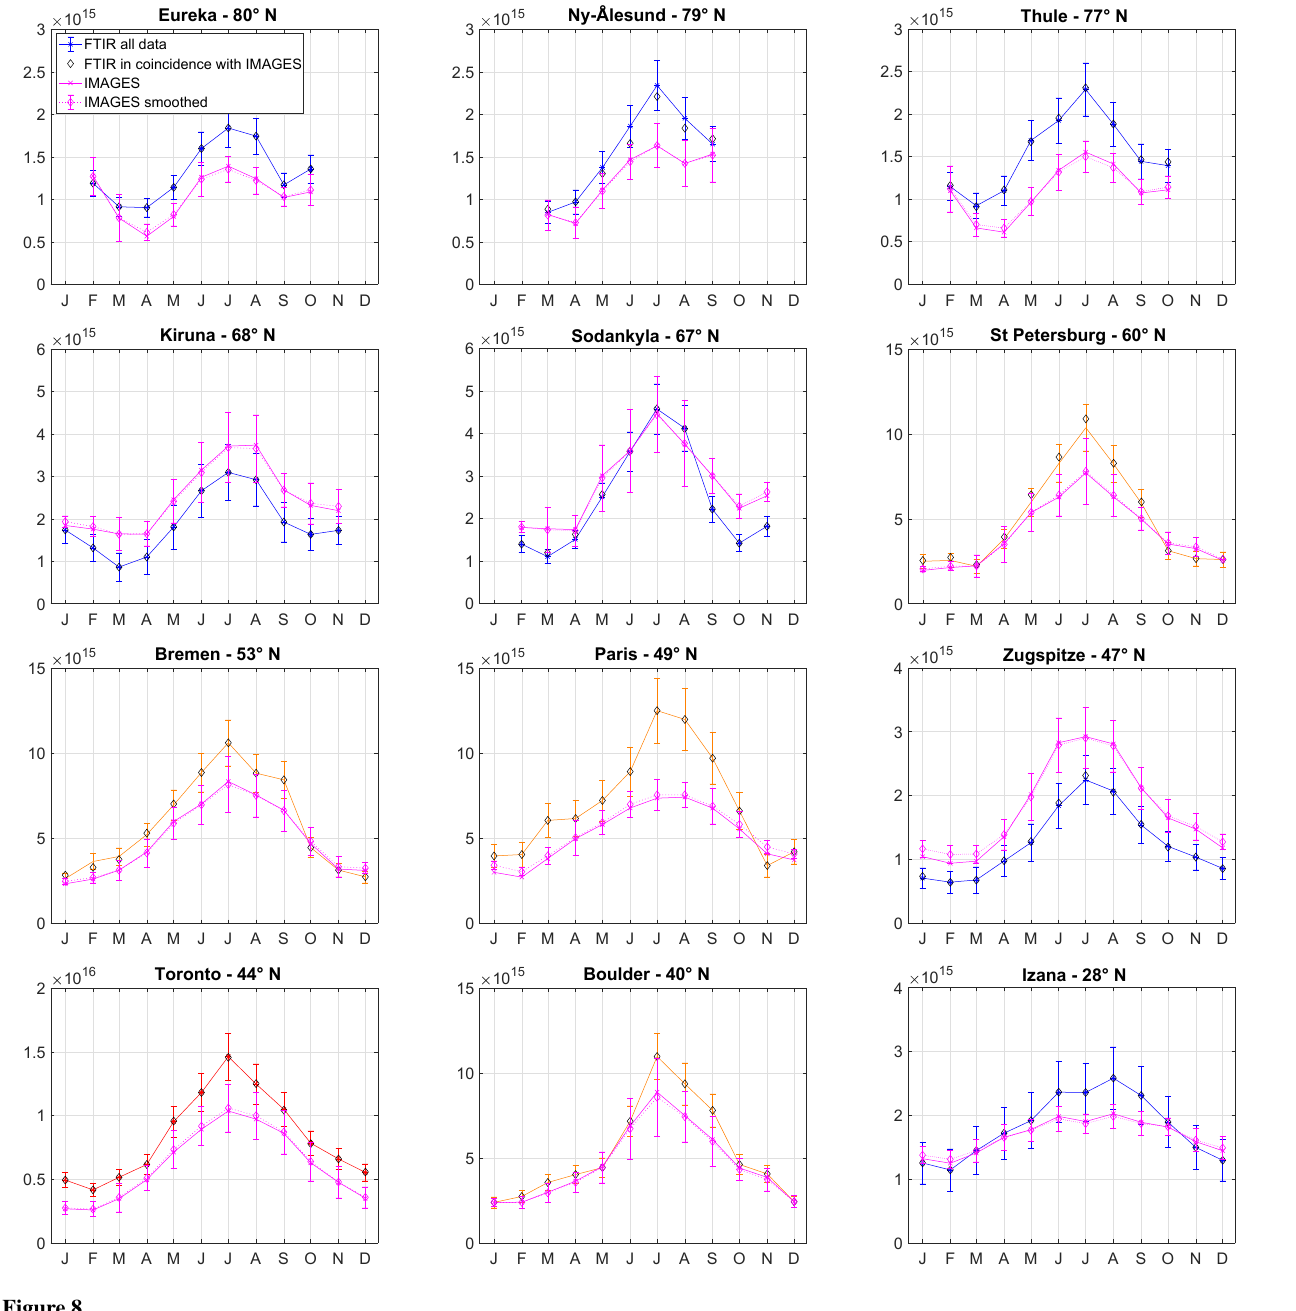
The North American sites Toronto and Boulder give similar biases ( − 26 %/ − 17 %), especially in summer ( − 25 %/ − 17 %). Toronto is the only midlatitude urban site where the model shows a higher underestimation of the HCHO levels in winter ( − 39